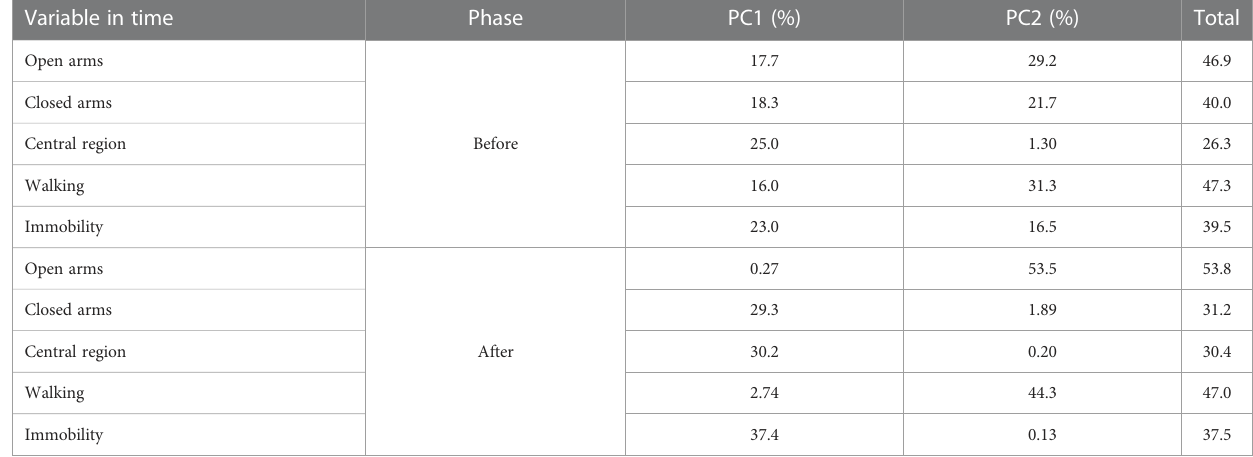
TABLE 7 Contributions (in percentage) of the variables to the principal components (PC1 and PC2) measured Elevated plus maze test before and after weaning of piglet ’ s. Variable in time